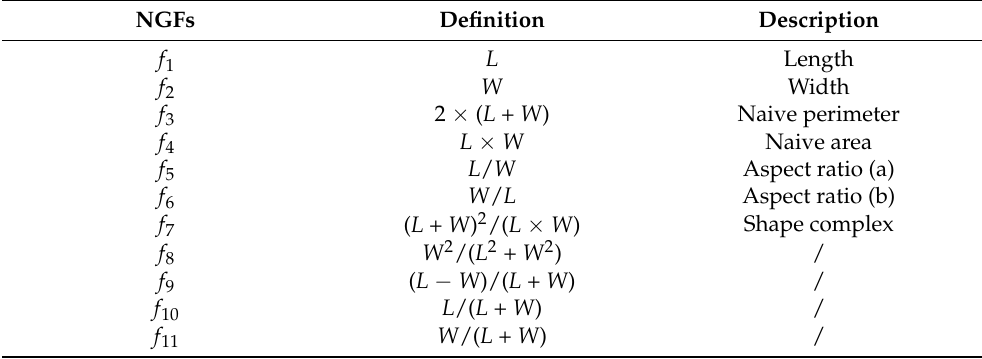
Table 1. Definition of NGFs. The length ( L ) and width ( W ) are both measured by pixel numbers.